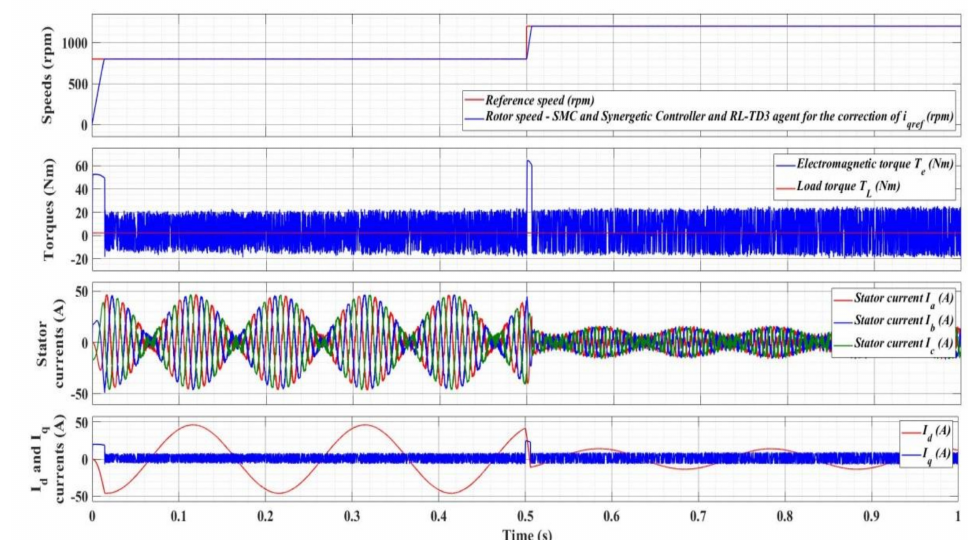
Figure 37. Time evolution for the numerical simulation of the PMSM control system based on control using SMC and synergetic controllers using an RL-TD3 agent for the correction of i qref : T L = 2 Nm with 0.2 Nm magnitude of uniformly distributed noise and 50% increase in J parameter.